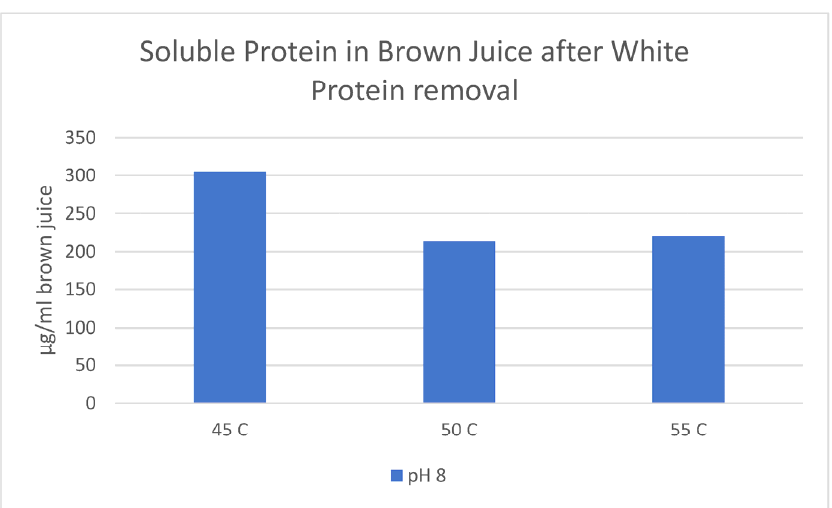
Figure A1. Soluble protein left in the brown juice after white protein removal at various temperatures.